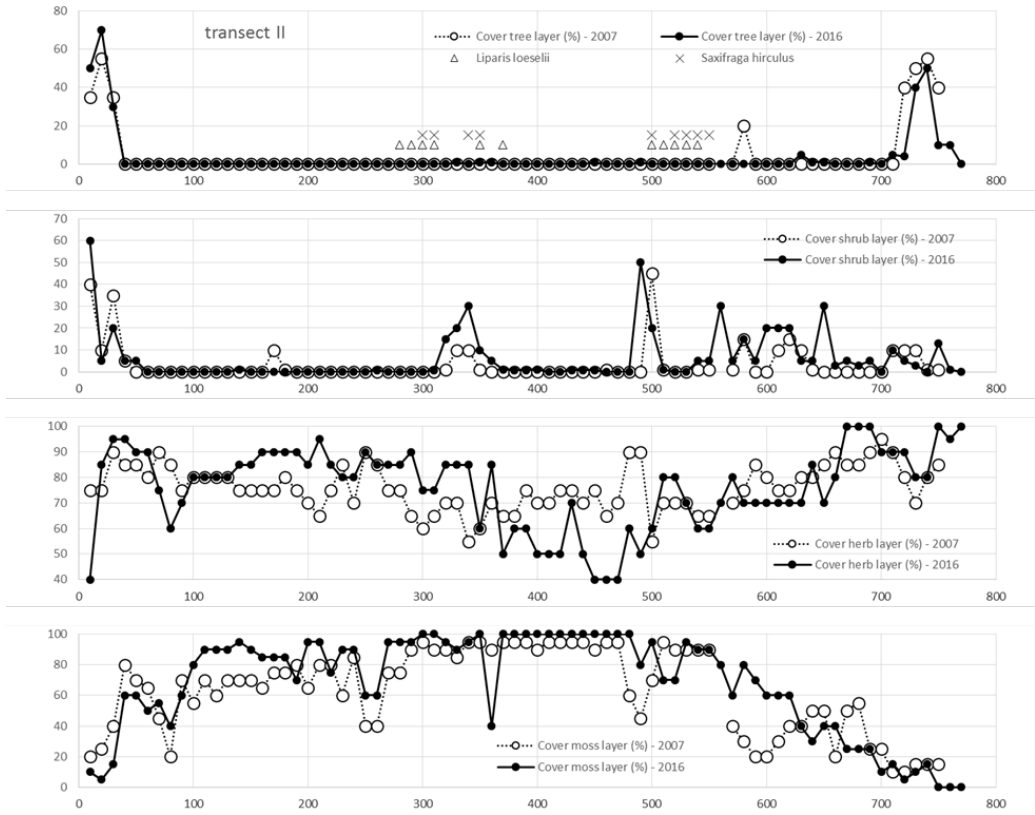
Figure 4. Cover of tree, shrub, herb and moss layers along Transect II, in 2007 and 2016. Relevés with Liparis loeselii and Saxifraga hirculus in 2007 are